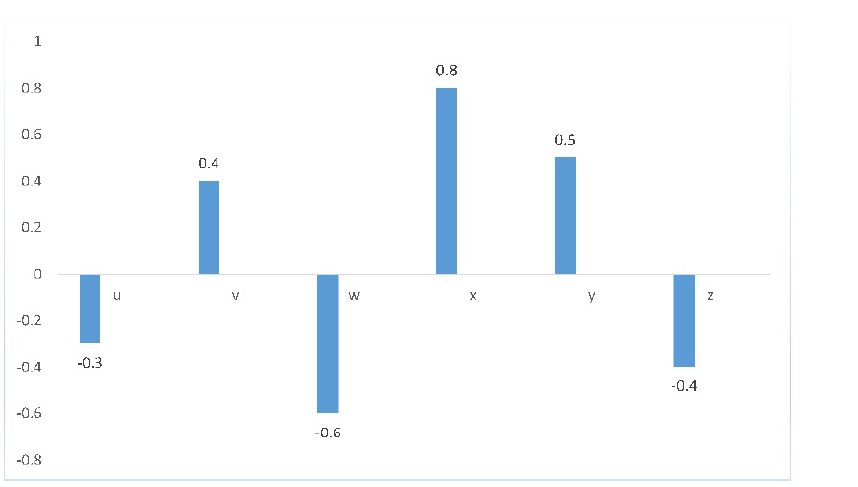
Figure 2. Graph of bipolar fuzzy